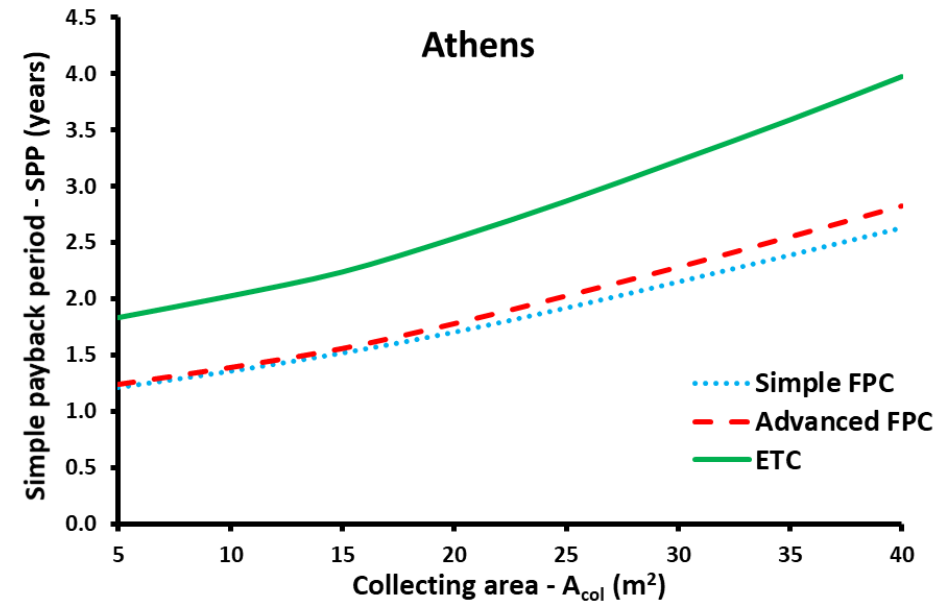
Figure 25. Simple payback period for different collecting areas and collector types for Athens.